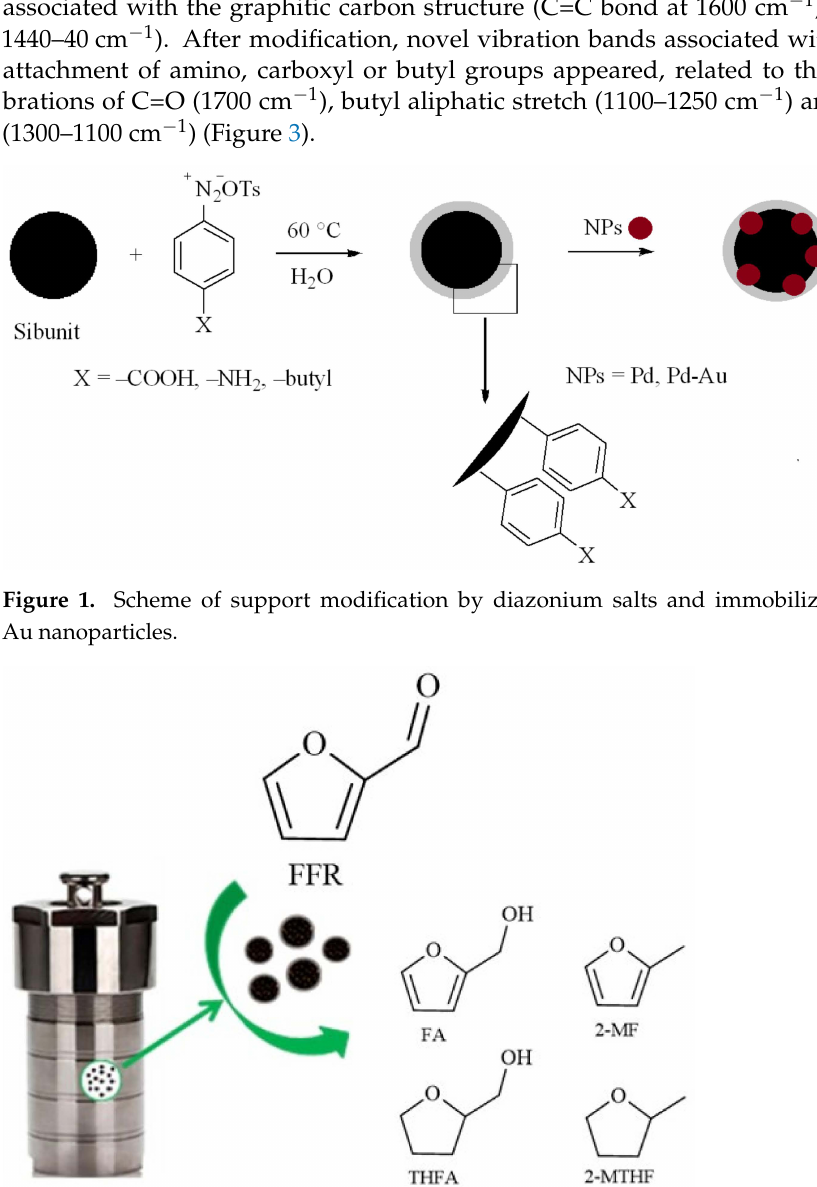
Figure 2. Schematic representation of the catalytic